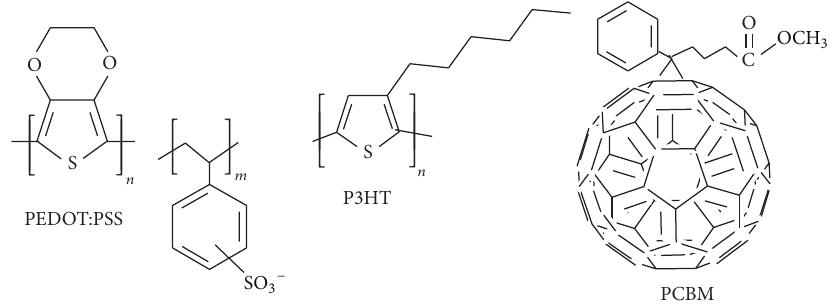
Figure 1: Chemical structure of PEDOT:PSS, P3HT, and